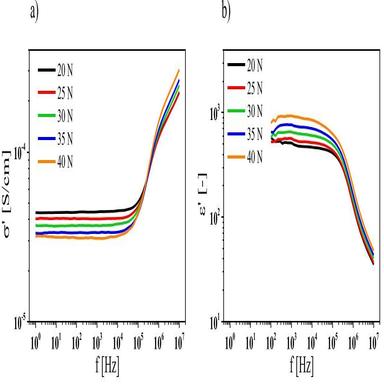
Real part of the complex conductivity (a) and complex permittivity (b) as a function of electrical frequency by varying static load from 20 N to 40 N.